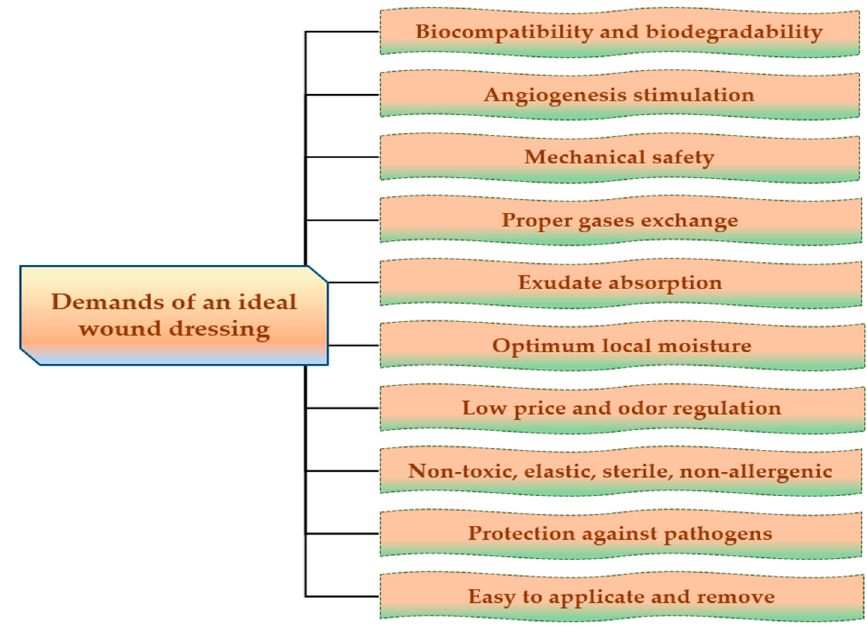
Figure 3. Major demands of an ideal wound